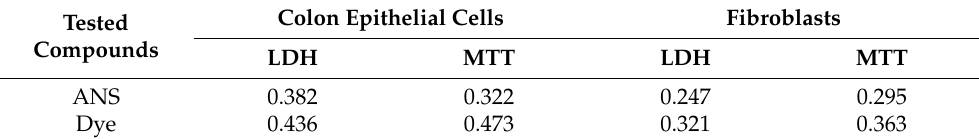
Table 2. Environmental toxicity of the ANS substrate and the dye after 5 min of exposure on V. fisheri bacteria, expressed as half maximal effective concentration (EC 50 ) according to the 81.9% Basic Test Microtox protocol.